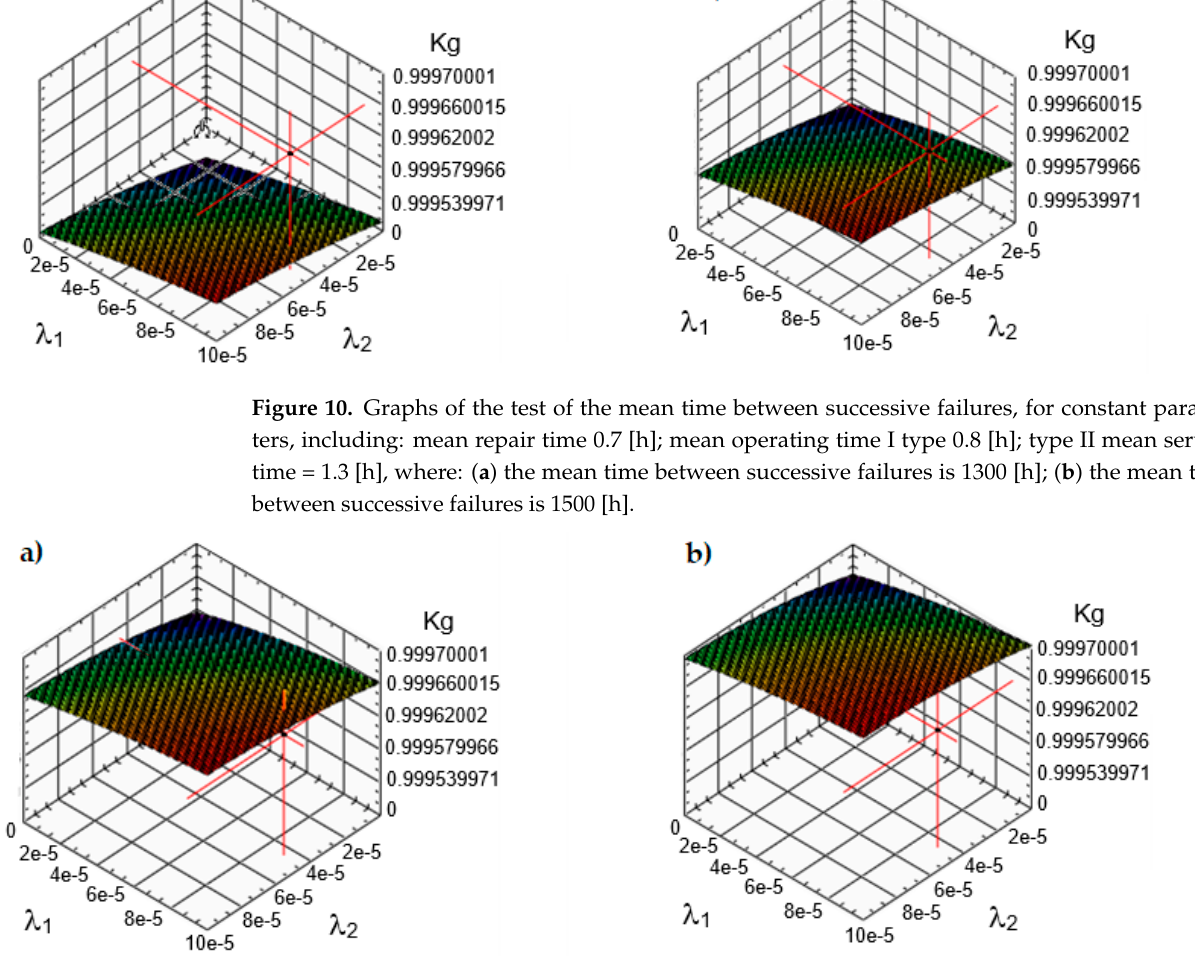
Figure 12. Graphs of the test of the mean time between successive failures, for constant parameters, including: mean repair time 0.7 [h]; mean operating time I type 0.8 [h]); type II mean service time = 1.3 [h], where: ( a ) the mean time between successive failures is 2500 [h]; ( b ) the mean time between successive failures is 3000 [h].